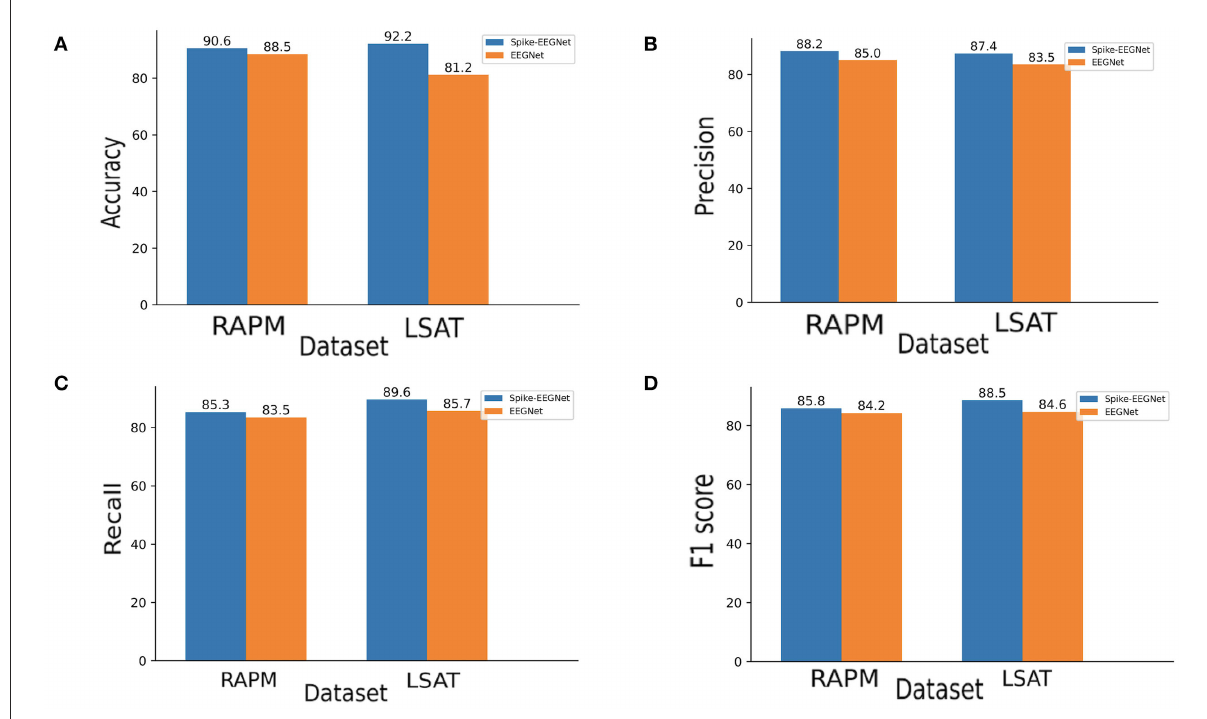
FIGURE6 The performance of Spike-EEGNet and the originial EEGNet on two datasets, (A) accuracy, (B) precision, (C) recall, and (D) F1 score—Spike-EEGNet and the originial EEGNet corresponding respectively to dark blue and orange histogram.